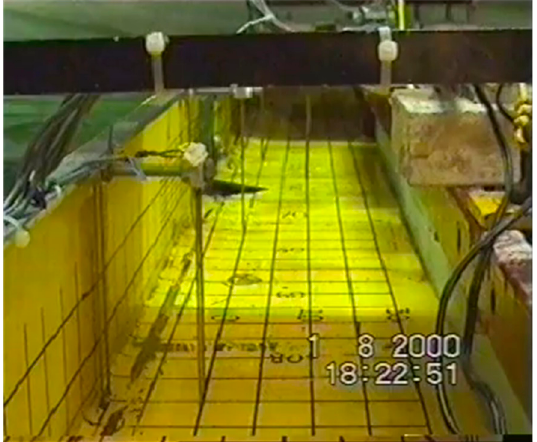
Figure 11. Typical RoPax flooding scenario with water on deck.